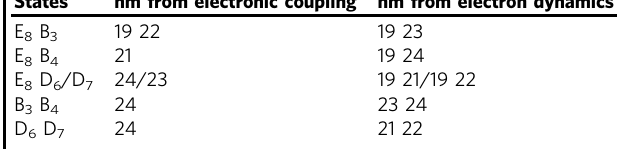
Table 1 Symmetry couplings for examples presented numerically in this work (see Supplementary Note 4 Figure S2 for full